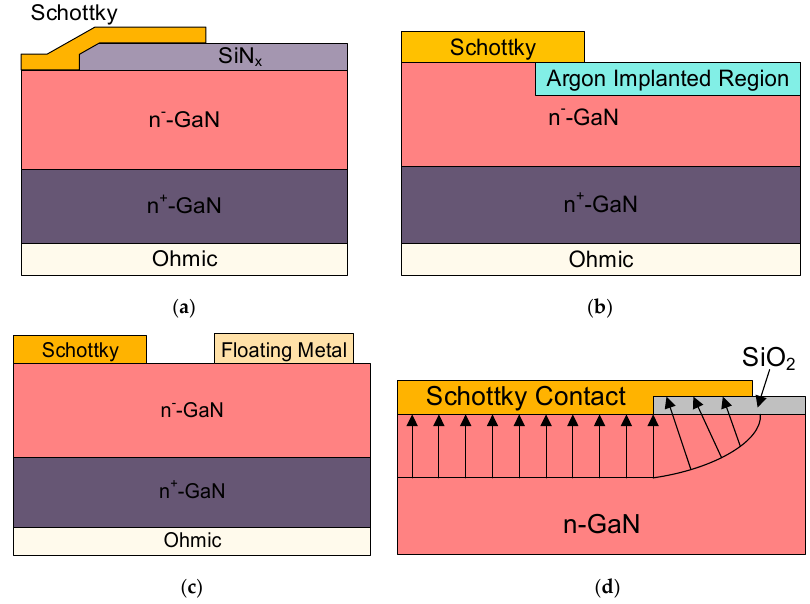
Figure 6. Schematic cross-section of a field plate with GaN SBDs: ( a ) metal field plate, ( b ) resistive field plate, ( c ) floating field plate, and ( d ) E-field distribution under reverse bias.